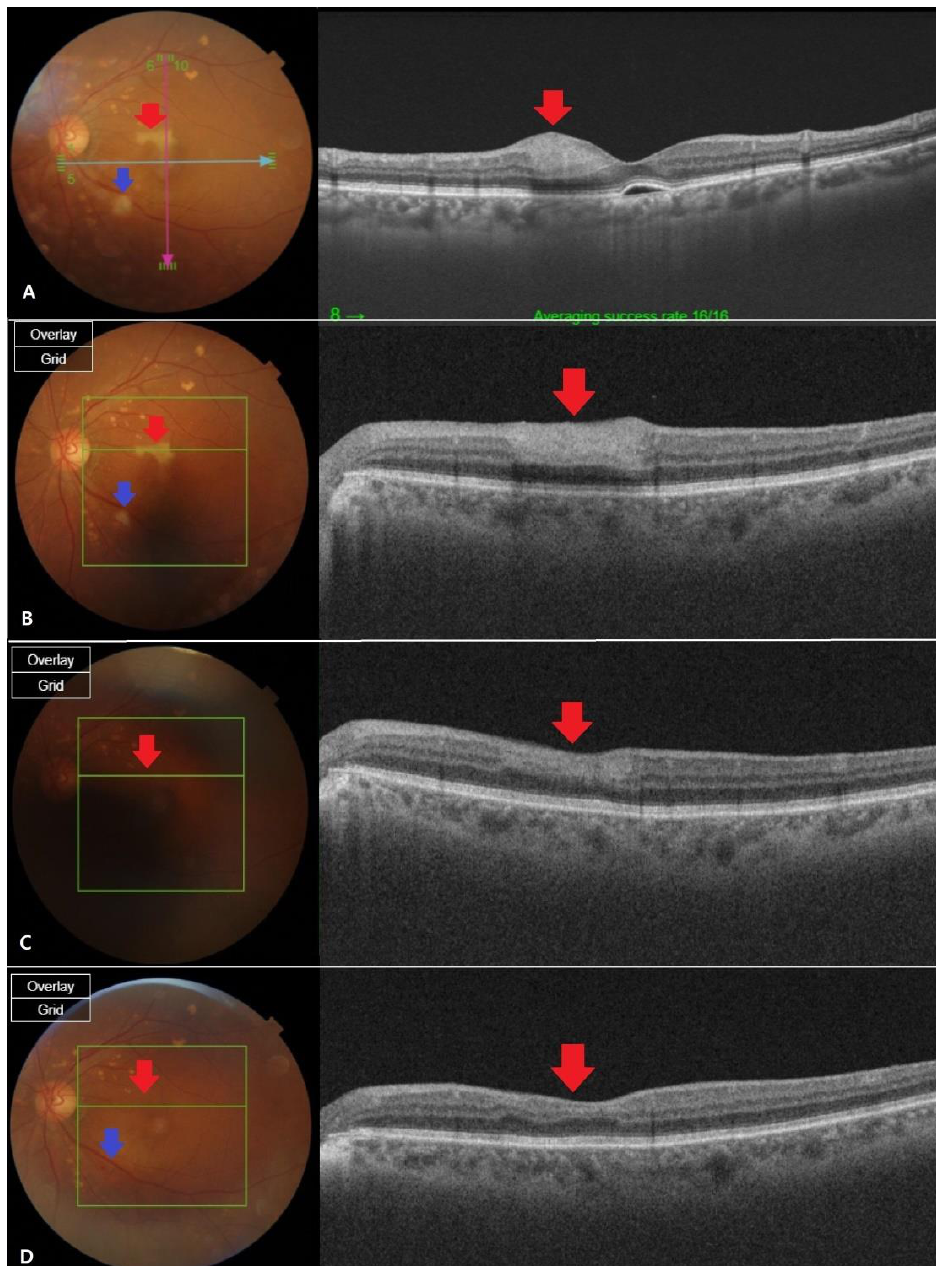
Figure 2. Fundus photography and optical coherence tomography (OCT) images at different stages of retinal artery occlusion (RAO). ( A ) The fundus findings were confirmed to be cilioretinal artery occlusion (CLRAO) by observing whitening and intraretinal thickness in the 12 o’clock direction near the macular on the day the symptoms occurred.There is a cotton wool patchfinding in the disc’s inferotemporal area, which is one disc dimeter away, showing branch retinal artery occlusion (BRAO). ( B ) After two weeks, the apparent finding of the whitening was not recovered (red arrow), but the intraretinal thickness of the OCT decreased.It is thought that the area of BRAO was reduced due to reperfusion (blue arrow). ( C ) After a month, the fundus found that the whitening area recovered and the intraretinal thickness was completely reduced in OCT, which was in normal range (red arrow). BRAO area was almost recovered, but still a little whitening was left (blue Arrow). ( D ) Two months later, full recovery was shown from the fundus findings (red arrow). Mild intraretinal thinning was shown in OCT (blue arrow), but the BRAO recovered so that it was almost indistinguishable by visual observation.